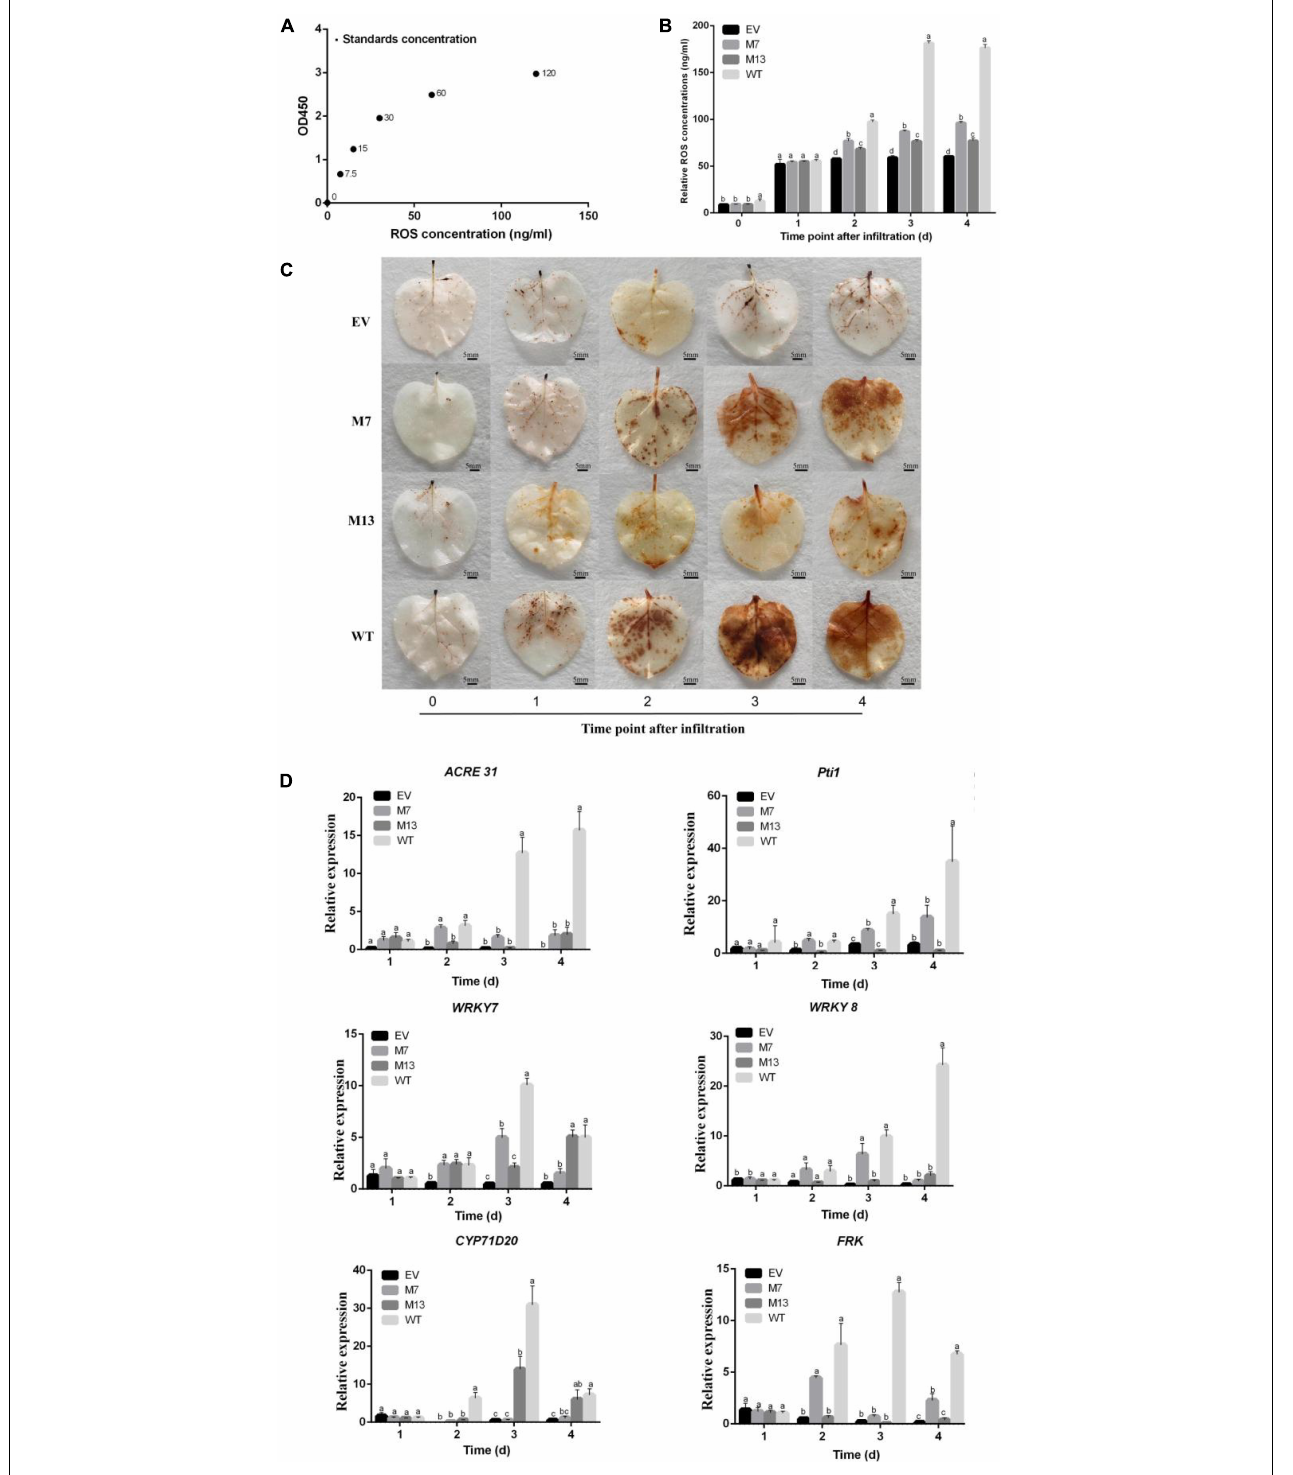
FIGURE 6 | Changes in ROS and gene expression in response to subtilisin mutants. (A) The standard curve was generated from the average optical density OD 450 obtained for each of the six plant ROS standard concentrations (0, 7.5, 15, 30, 60, and 220 ng/ml). (B) The ROS concentration of N. benthamiana expressing pK7WG2D control (EV), subtilisin-p7 mutants (M7), subtilisin-p13 mutants (M13), and wild-type subtilisin (WT) were measured by ELISA at various times (0, 1, 2, 3, and 4 days). (C) Accumulation of ROS was analyzed in N. benthamiana leaves expressing pK7WG2D control (EV), subtilisin-p7 mutants (M7), subtilisin-p13